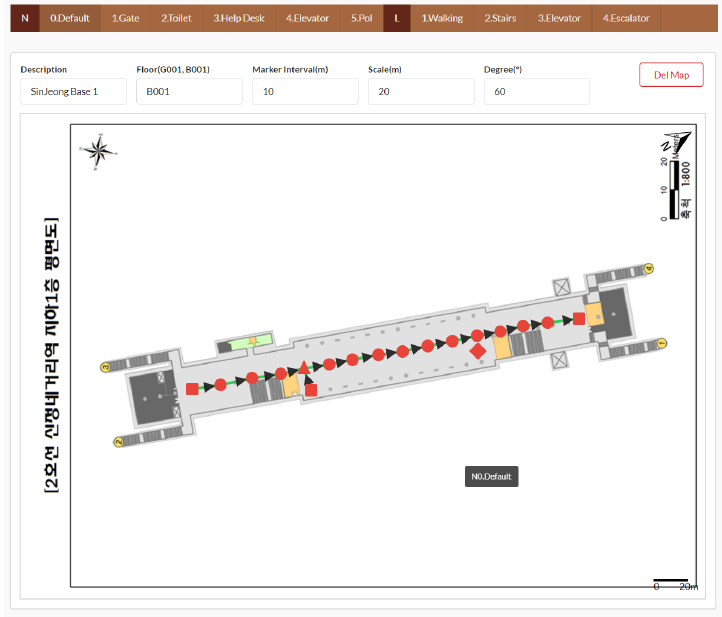
Figure 2. Planning tool of the HMIPS.